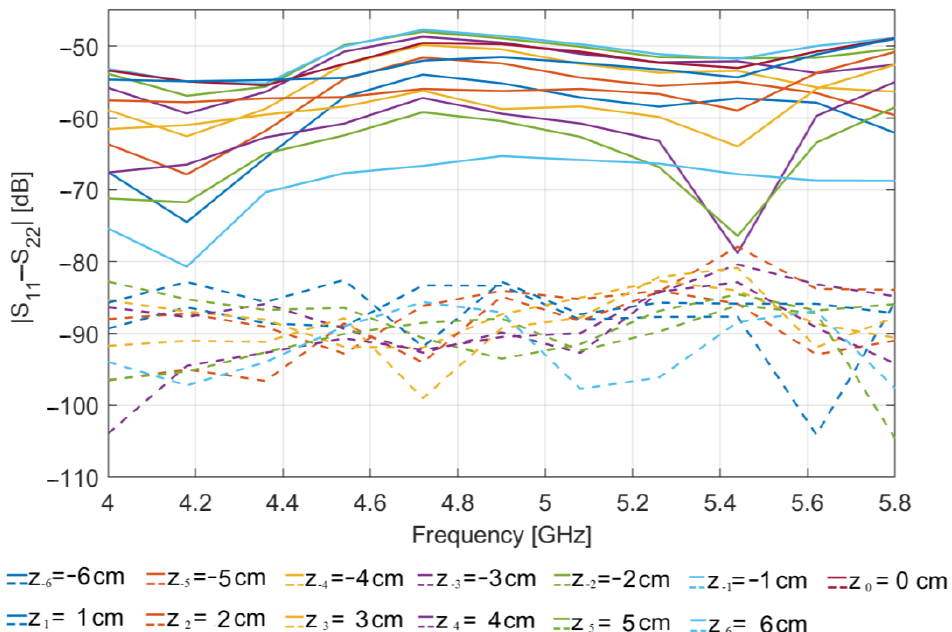
Figure 5. Simulated |S 11 (z n ) – S 22 (z n )| (in dB) vs. frequency: OUT with an 8 mm glass inclusion (solid lines); OUT free of inclusions (dashed lines).